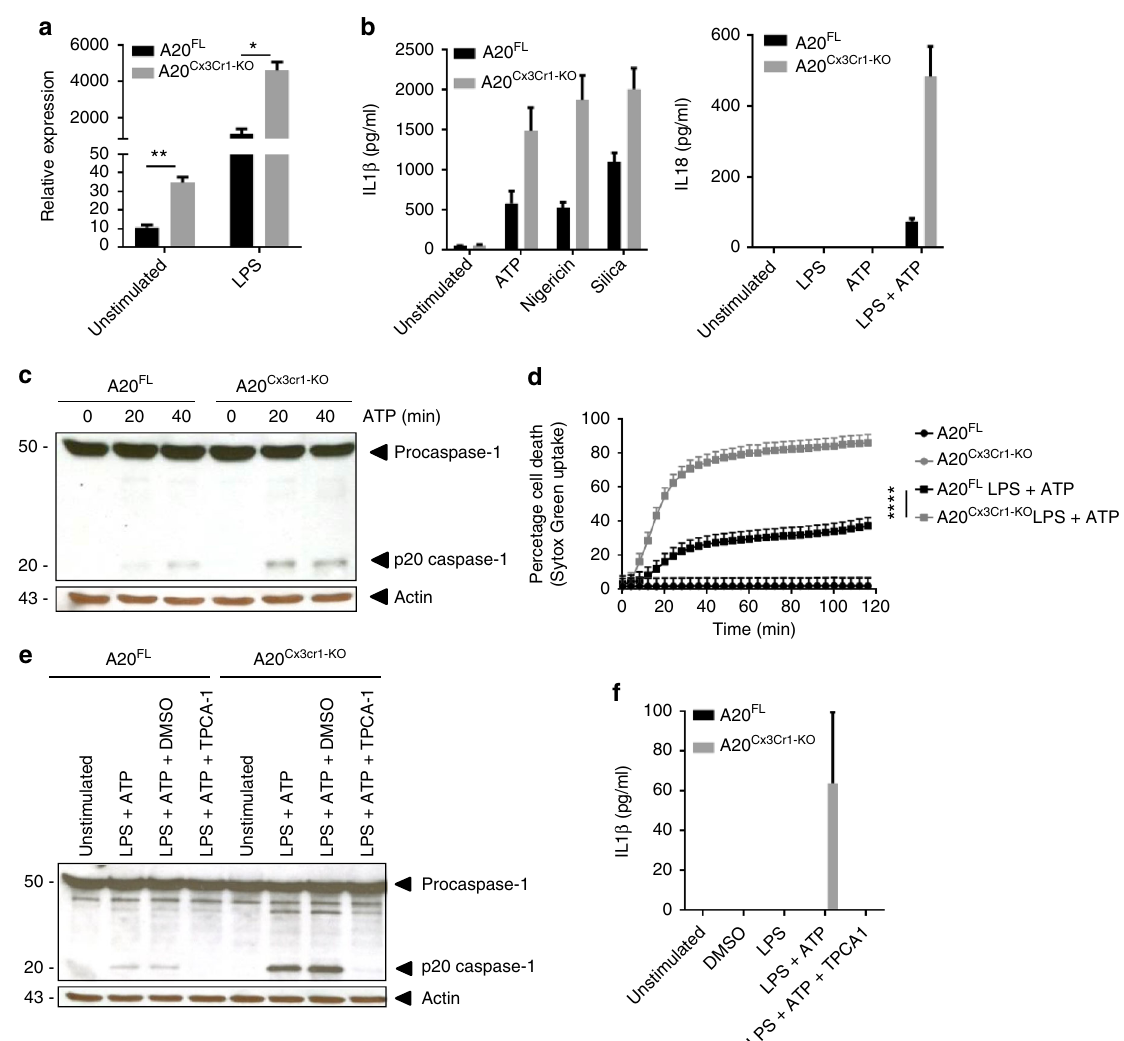
Fig. 4 A20 Cx3Cr1-KO microglia are hypersensitive to Nlrp3 in fl ammasome activation. a IL-1 β mRNA expression in microglia from A20 Cx3Cr1-KO mice compared with control mice either or not injected with LPS. Data are presented as mean ± SEM. Signi fi cant differences were determined by a Mann – Whitney t -test (* p < 0.05, ** p < 0.01). b IL-1 β and IL-18 protein levels in the supernatant of primary cultured microglia stimulated with LPS alone